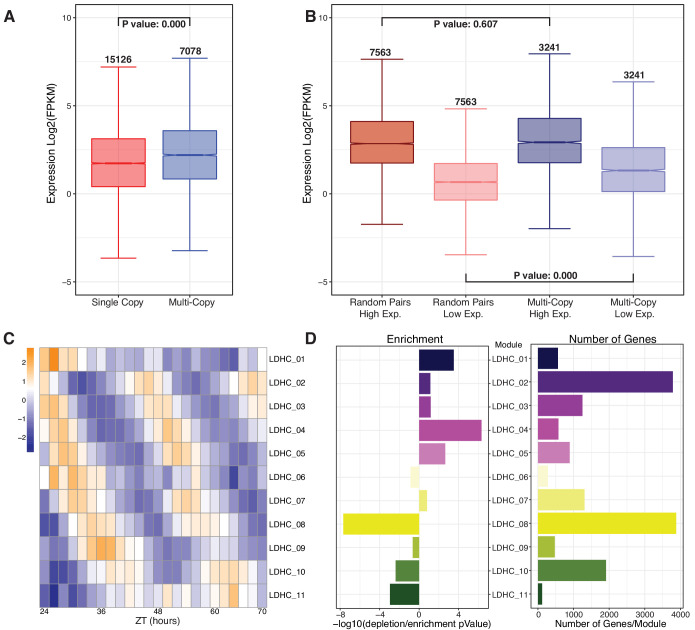
Retained multi-copy circadian regulated genes are highly expressed and display time of day variation.(A) Mean log2 FPKM expression levels for each gene across the combined LD and HC time course for multi-copy paralogs compared to single-copy genes. Numbers above the whiskers indicate the number of genes in each group. P-value is the result of a one-way ANOVA with Tukey’s test. (B) Expression level comparison when paralogs are separated into high and low expression groups compared to randomly paired single-copy genes. Numbers above the whiskers indicate the number of genes in the groups. P-value is the result of an ANOVA test. (C) Heatmap of the 11 modules of the combined LDHC co-expression network arranged by ZT time (in Zeitgeber [ZT] time, where ZT0 represents the most recent dark to light or cold to warm transition) across the x-axis and circadian phase along the y-axis. (D) Results of a hypergeometric test of the number of multi-copy genes in each module. The left barplot shows the results of the hypergeometric test expressed as a -log10 pValue with enrichment to the right and depletion to the left of 0. The right barplot shows the number of multi-copy genes in each of the modules.